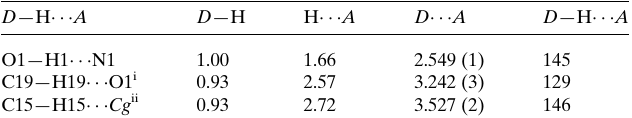
Table 1 Hydrogen-bond geometry (A˚ , (cid:2) ).